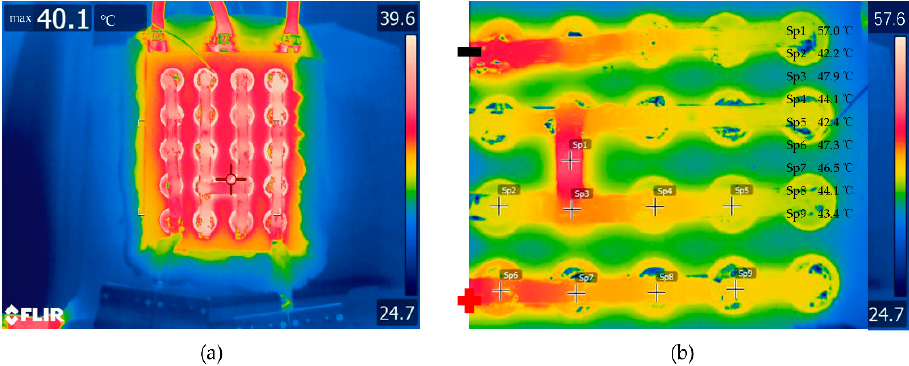
Figure 9. Thermal imaging of battery module nickel busbars under the conditions of 2C, 40 ◦ C, and ( a ) 0 s or ( b ) 1590 s (the end of discharge), with the spot temperatures Sp1–9 marked in the right upper corner.